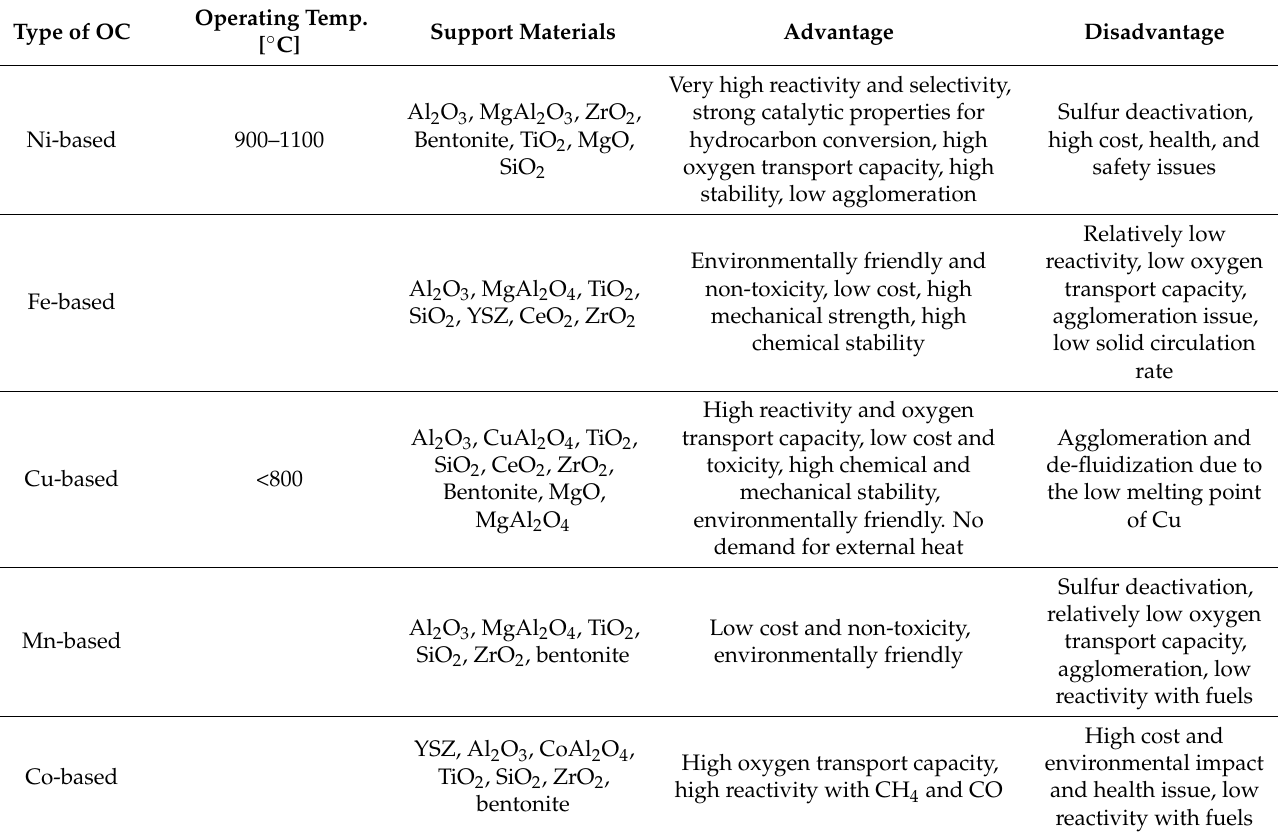
Table 3. Overview of common types of oxygen carriers in chemical looping processes [9,11,12,14,18]. Type of